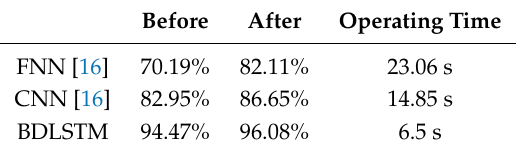
Table 2. Accuracy performance before and after collision avoidance with n =